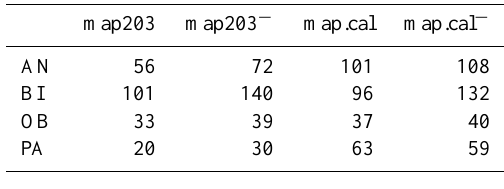
Table 4. RMSEs [mm] at the stations Anniviers Orzival (AN), Binn (BI), Obersaxen (OB) and Parsenn Kreuzweg (PA). Map203 and map.cal are the original versions. Map203 − and map.cal − are the maps with the four stations removed.